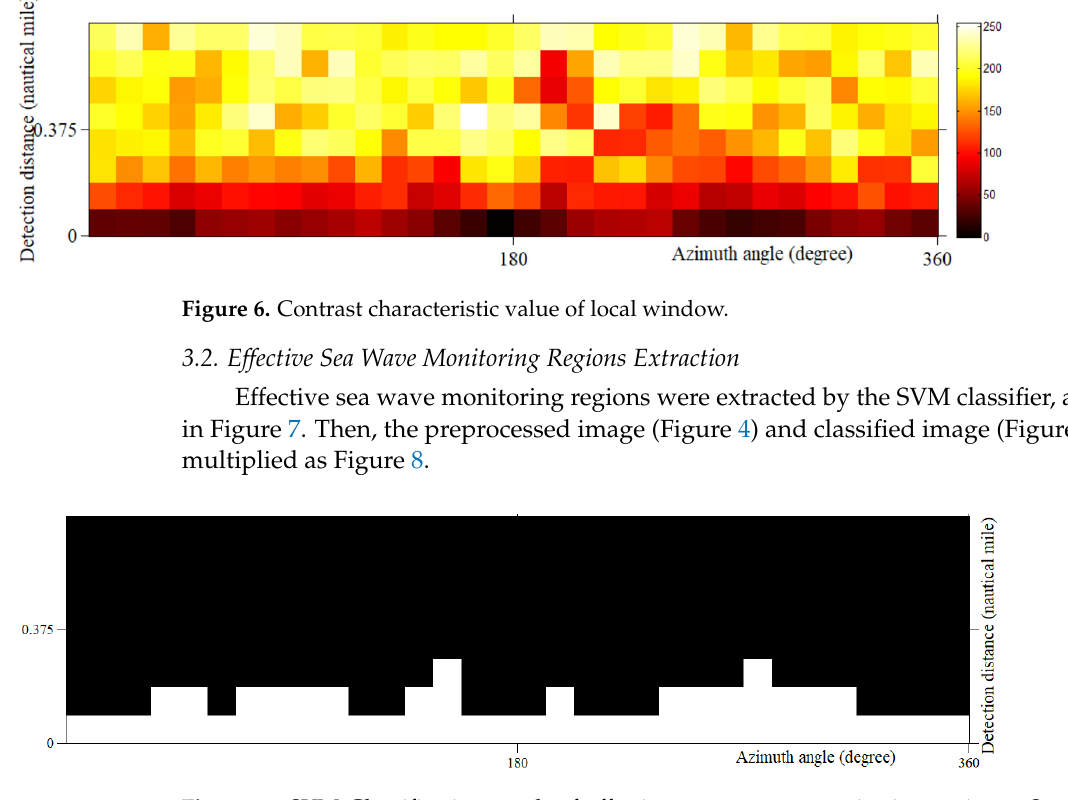
Figure 8. Result of effective ocean wave monitoring regions. 3.3. Oil films Identificaiton FCM was used to divide Figure 8 into 3 classes after 15 iterations as Figure 9a. The class with the lowest value was multiplied by Figure 7 as the rough oil films segmentation, as shown in Figure 9b. After that, the speckles and false positive targets caused by the ship's wake were deleted to obtain the oil film identification result as Figure 10. This pro- cess takes 26.71 s on average. Finally, the identification result is transformed into the polar coordinate system as Figure 11. ( a ) ( b ) Figure 9. Rough oil films segmentation result. ( a ) FCM classification; ( b ) Rough segmentation result.